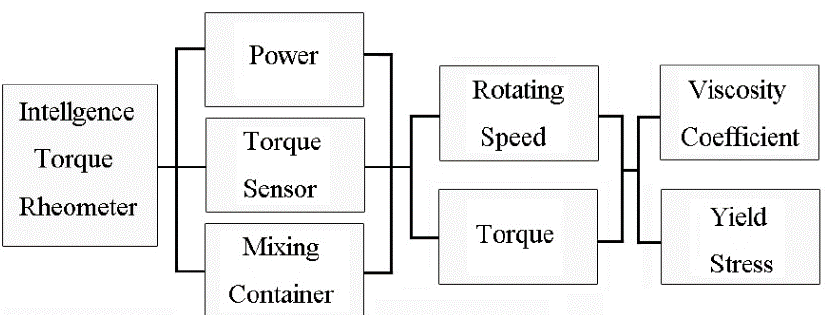
Figure 3. Intelligent Torque Rheometer.